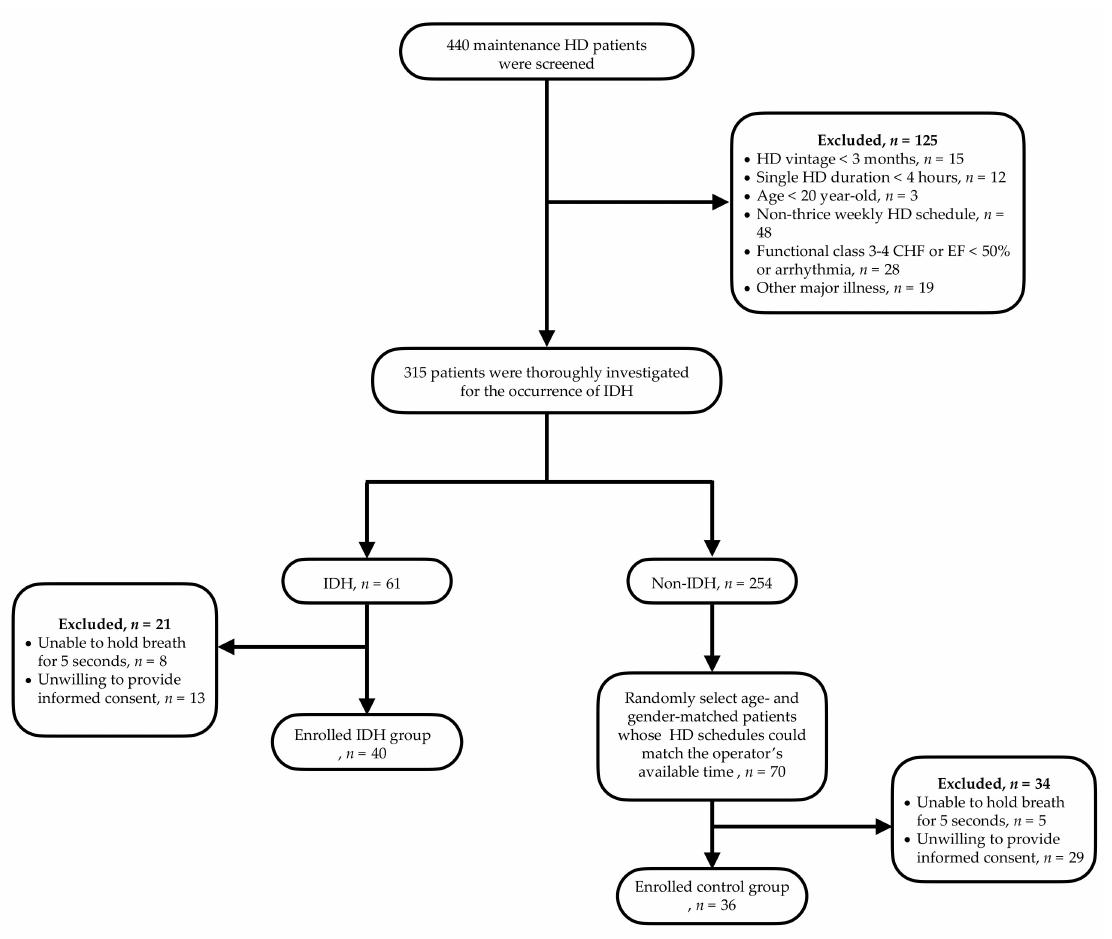
Figure 1. Flow chart of selection of study